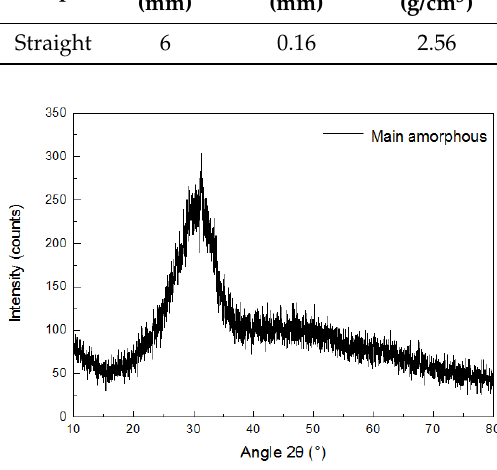
Figure 1. XRD patterns of GBFS.